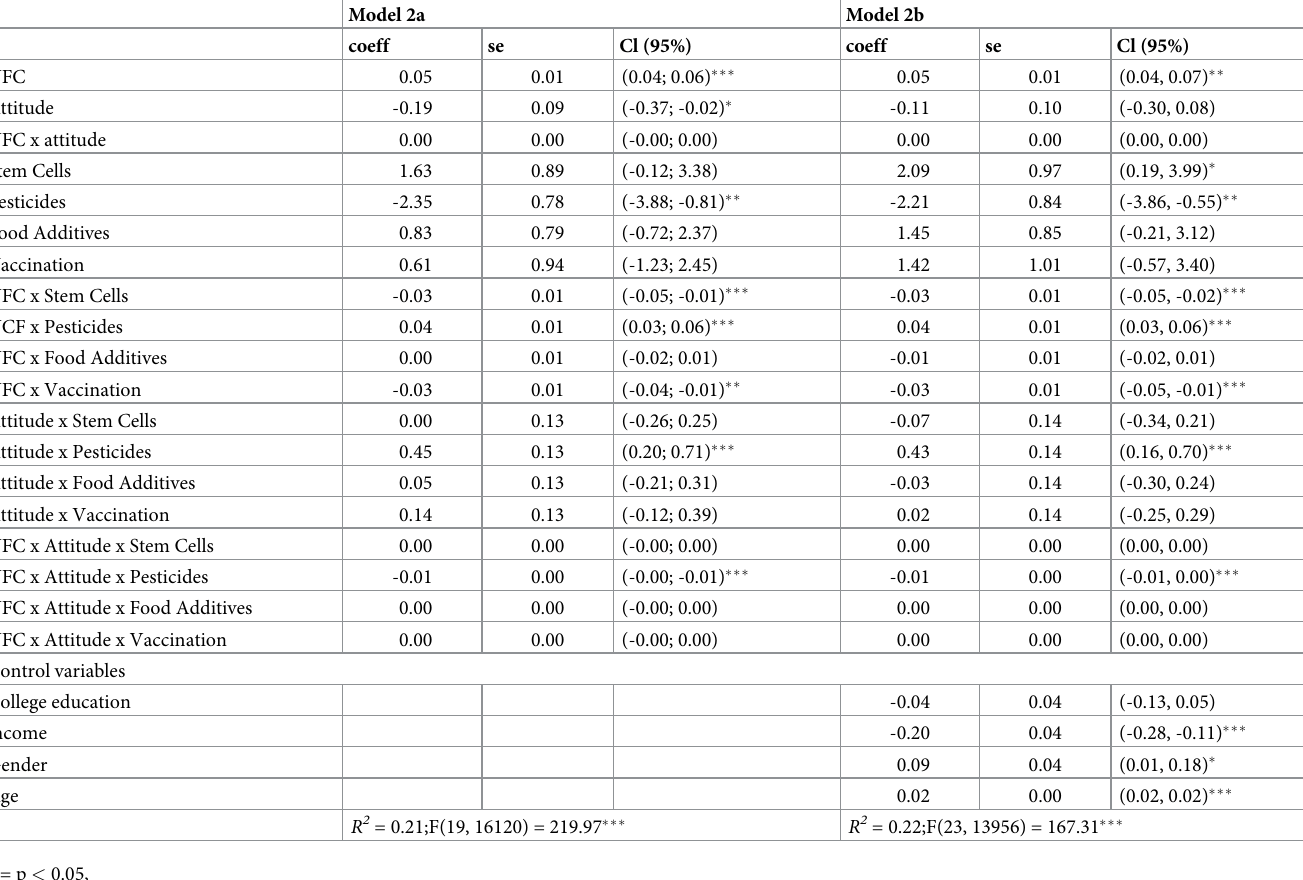
Table 5. Moderated moderation effects of attitude (W) and technology (Z) on the relationship between NFC and distance between perceived harms and benefits for the environment (Model 2b includes demographics as controlled